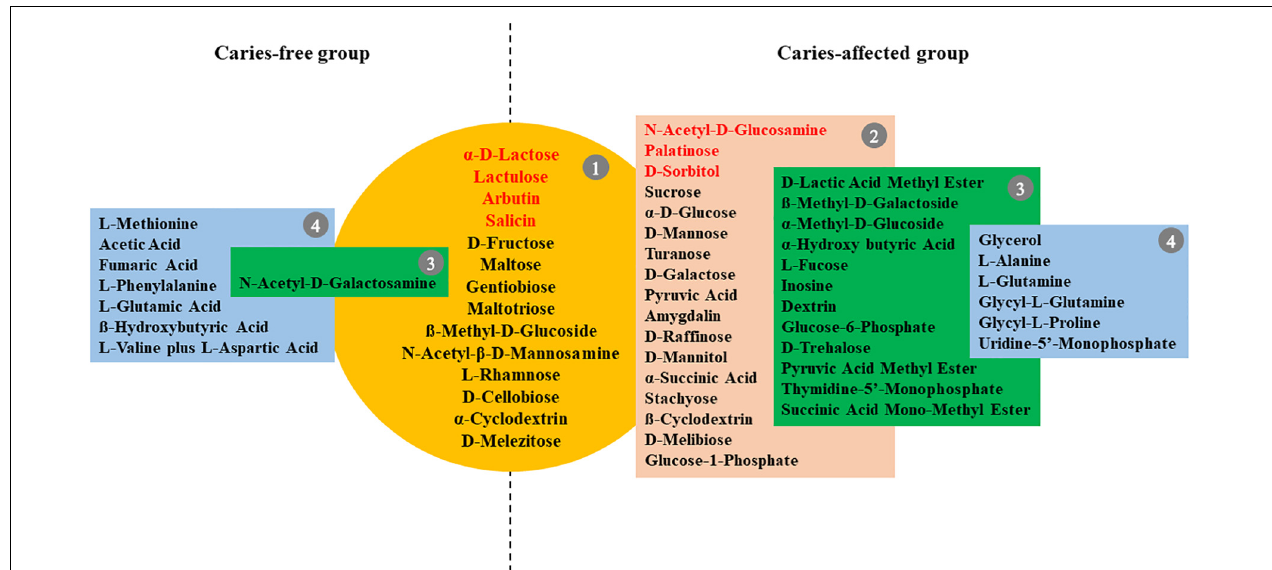
FIGURE 2 | Core-positive carbon sources of CF and CA group. Metabolic reaction positive wells found in at least 90% of subjects in the CF or CA groups after 96 h incubation were defined as core-positive carbon sources. Group 1 (in yellow circle) are core-positive carbon sources shared by CF and CA; group 2 (in brown box) contains CA-specific core-positive carbon sources; seven carbon sources in group 1 and group 2 which were utilized by plaque microbiota of 100% subjects in the CA group were highlighted in red font. Carbon sources utilized by 80–90% of plaque microbiota from individuals in one group but by < 80% in the other group are listed in group 3 (in green box); carbon sources utilized by 50–80% of plaque microbiota from individuals in one group but by < 50% in the other group were listed in group 4 (in blue box).